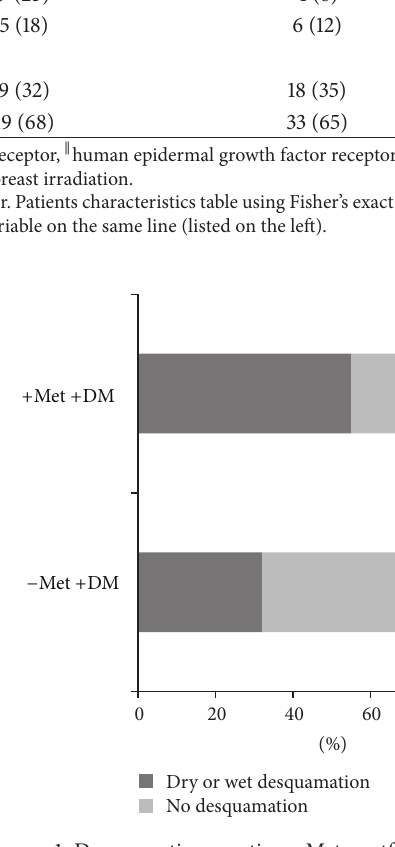
Figure 1: Desquamation reactions. Met: metformin, RT: radiation therapy. Acute skin toxicity comparing frequency of desquamation in patients receiving concurrent metformin and radiation therapy versus patients receiving an alternate diabetes medication and